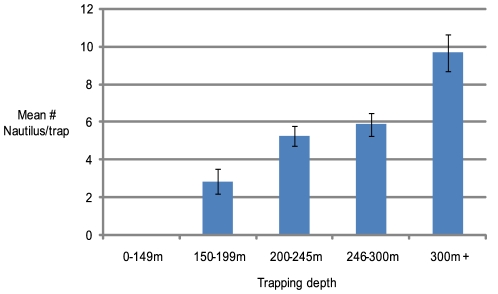
Comparison of Nautilus capture rates with trapping depth.The influence of depth on capture rates was analyzed for 271 trapping events spread throughout all months of the year. The most effective capture depths were around 300 to 350 m, while no captures were recorded from 18 trapping efforts at depths <150 m. Error bars (±1 standard error of the mean) are shown.